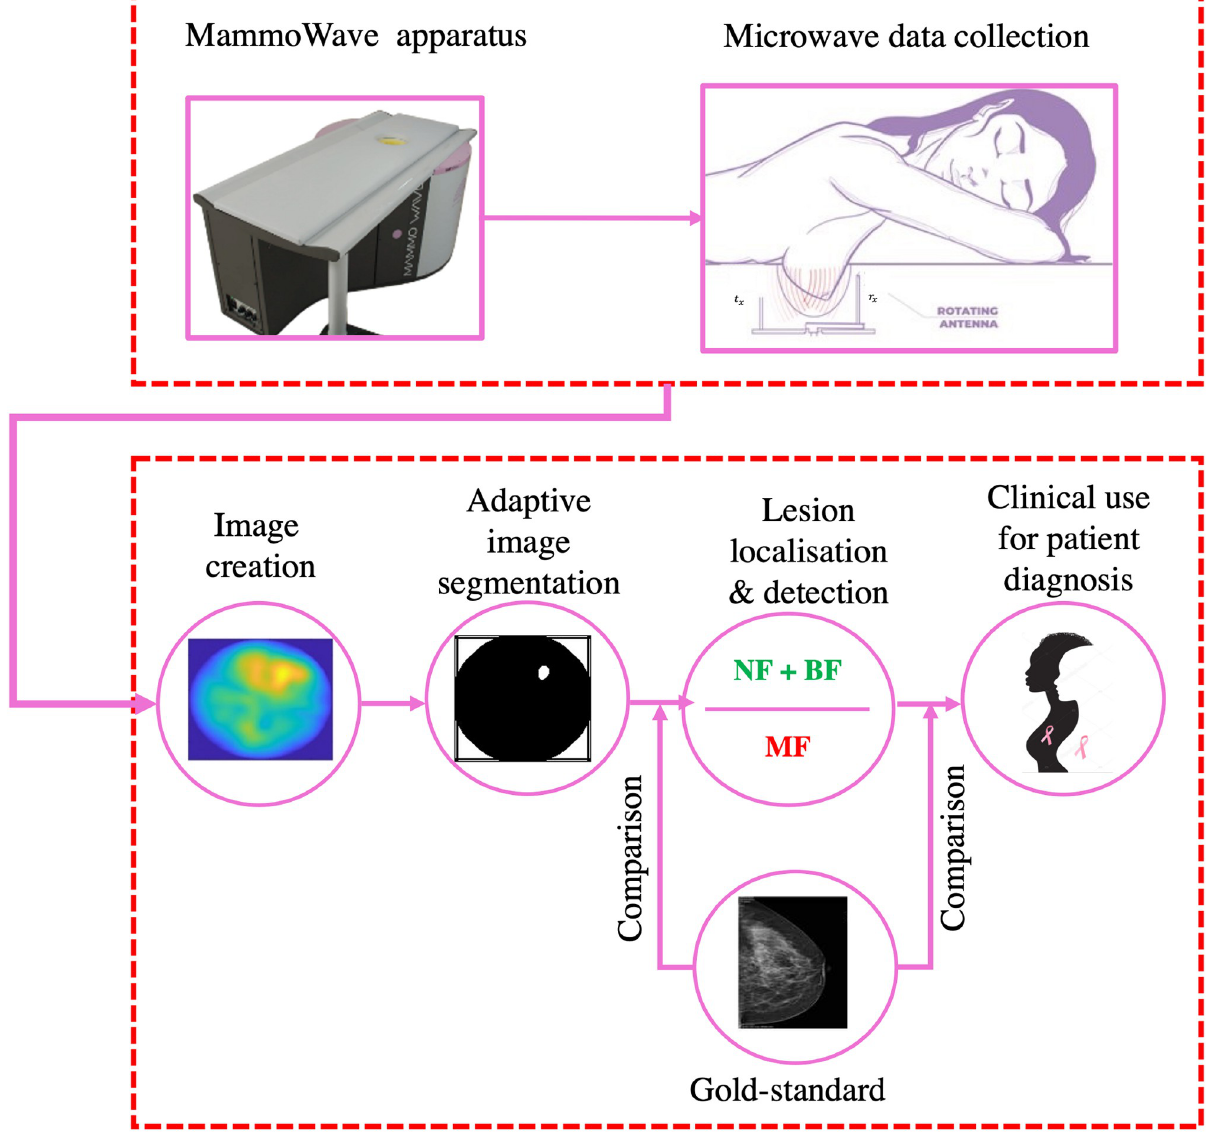
Fig 1. Flow chart of the proposed work; the clinical data collection procedure using MammoWave system and the proposed lesion localisation using the MammoWave created images.